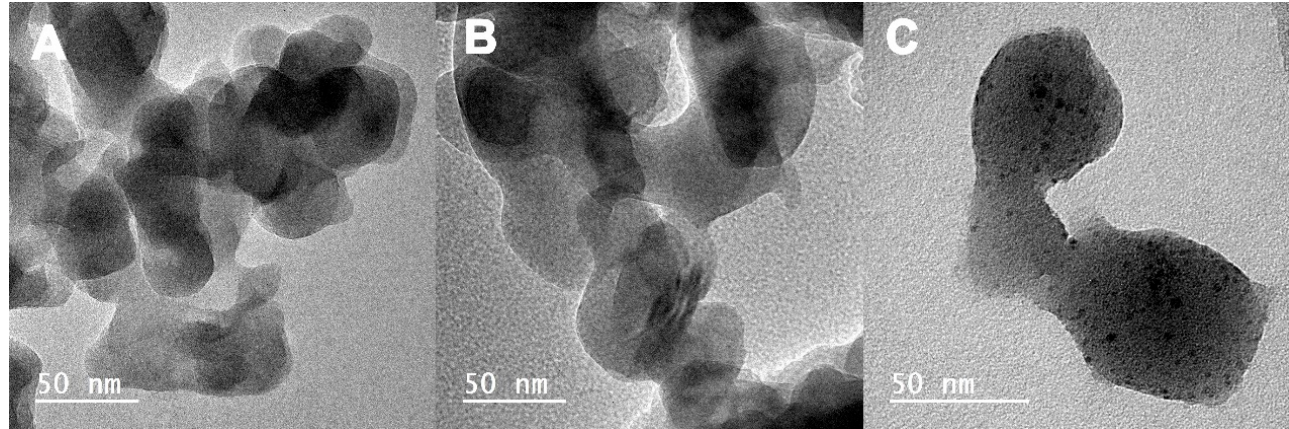
Figure 4. TEM micrographs of calcium magnesium silicate Ak powder samples: ( A ) Ak-neat, ( B ) AK Sr-doped, and ( C ) Ak Sr and Cu co-doped.